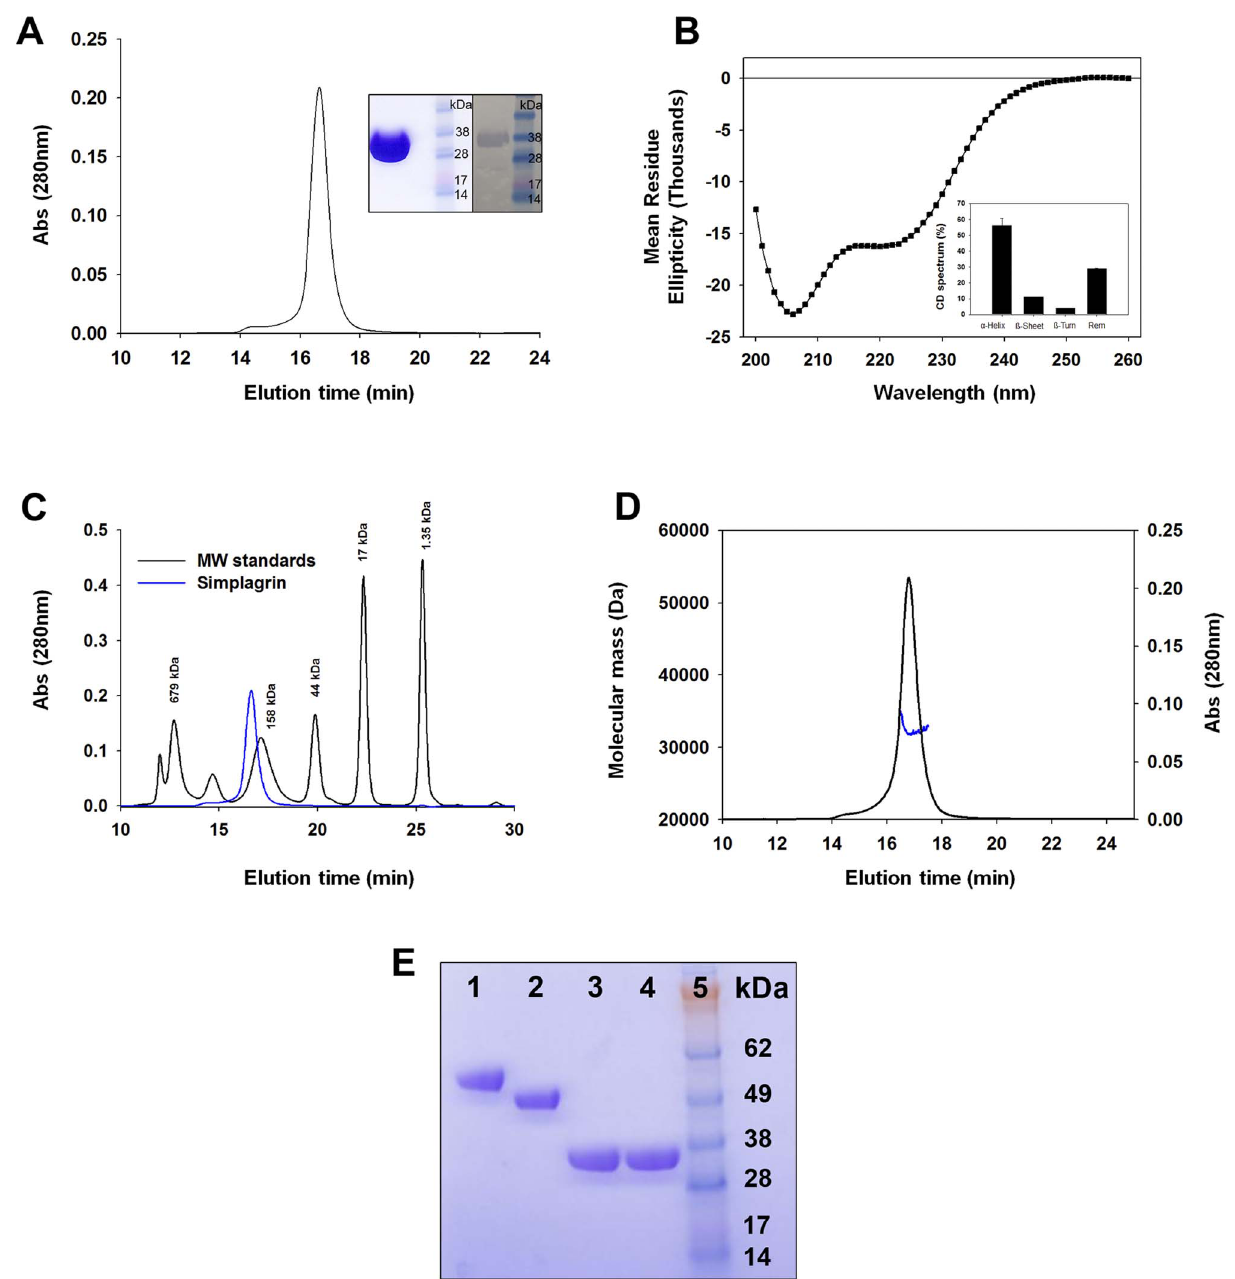
Figure 2. Expression of recombinant Simplagrin and biophysical analysis. (A) Recombinant Simplagrin was expressed as a secreted protein in HEK293 cells. Supernatant containing Simplagrin was concentrated and loaded onto a Ni + 2 -Hitrap column for affinity purification and further purified to homogeneity by size exclusion chromatography. Inset: Coomassie stained NuPAGE and western blot using rabbit anti-Simplagrin antibodies. (B) Circular dichroism (CD) spectroscopy analysis of Simplagrin shows that it mainly comprises a -helix (59%) followed by unordered/ disorganized (29%) secondary structures. Inset shows the calculated percentages of secondary structures determined by CD analysis. (C) Analytical size exclusion chromatography shows that Simplagrin runs at a higher than expected molecular weight. (D) Hydrodynamic property of Simplagrin demonstrates its monomeric, elongated form with a hydrodynamic radius of 5.6 nm. The calculated molecular weight of Simplagrin by dynamic scattering plot was 32 kDa (blue line in the chromatogram). (E) Recombinant Simplagrin is not glycosylated in HEK293 cells. Evaluation of putative glycosylation of recombinant Simplagrin was evaluated using DeGlycoMx kit. Fifteen m g of Simplagrin or Lundep (positive control) were heat denatured and treated with an enzymatic deglycosylase mix. After three hours at 37 u C, samples were electrophoresed in a NuPAGE-MES and stained with Coomassie blue. Lane 1: Lundep, 2: Lundep + DeGlycoMx, 3: Simplagrin, 4: Simplagrin + DeGlycoMx, 5: mW standard (SeeBlue Plus2 in kDa). doi:10.1371/journal.pntd.0002947.g002 chip and different analytes were flowed over the sensor’s surface. III, IV, V, and VI, and type I from rat tail) as the molecular Despite the low similarity between Aegyptin and Simplagrin at the partner of Simplagrin (Figure 3A). No detectable binding amino acid level, SPR analysis identified collagen (human types I, was observed to vitronectin, fibronectin, fibrinogen, vWF,